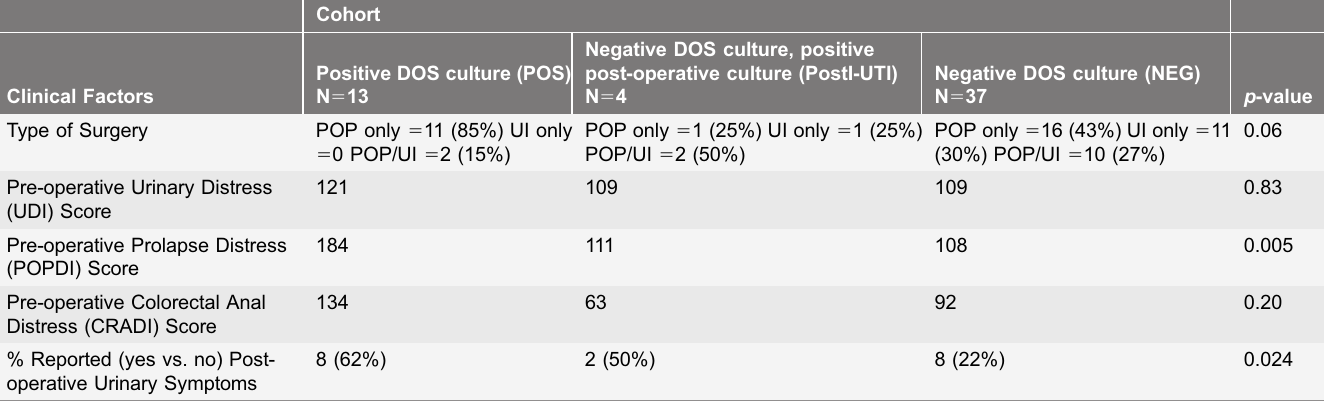
Table 1. Comparison of Pelvic Floor Characteristics Based on Culture